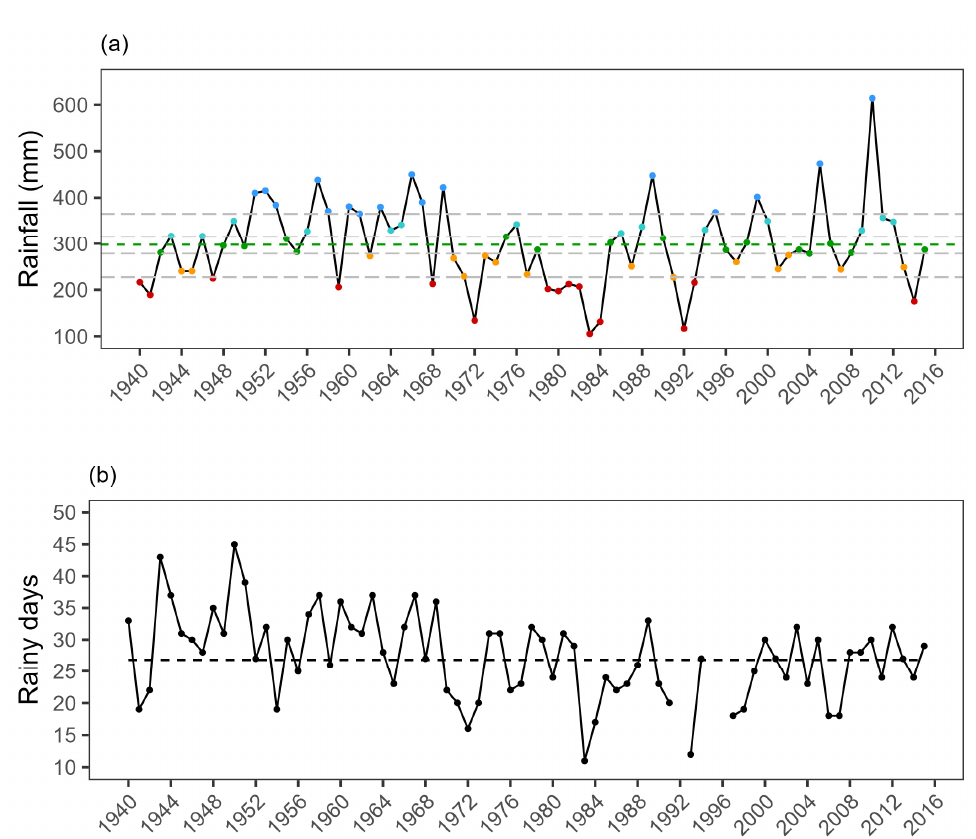
Figure 2. Rainfall in the study area from 1940 to 2015. ( a ) Annual rainfall (mm) [28,62]. Dashed green line represents the long-term mean and grey dashed lines represent the quantiles of the distribution. ( b ) Number of rainy days (>1 mm; computed from the Agrhymet—IRD database). Dashed line represents the long-term mean.